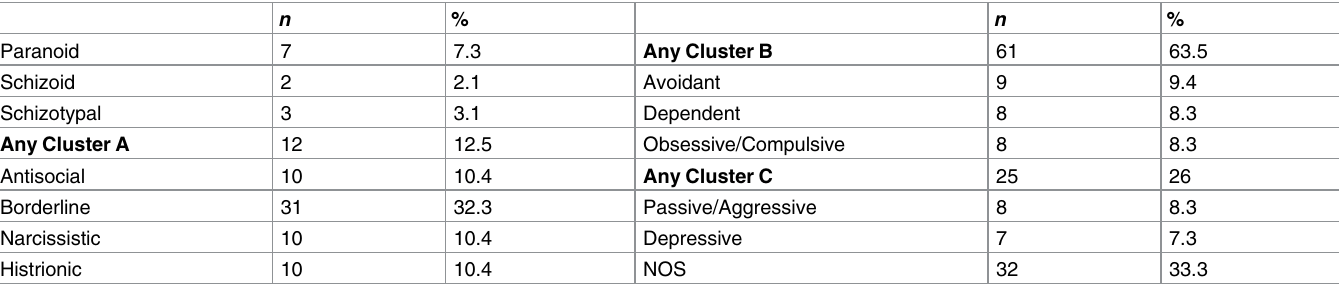
Table 1. Prevalence of Personality Disorders in the clinical